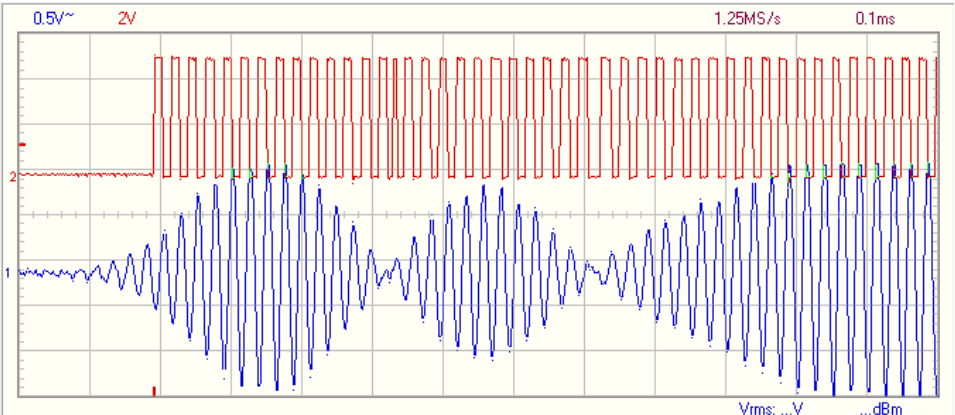
Figure 13. Received signal after obstacle